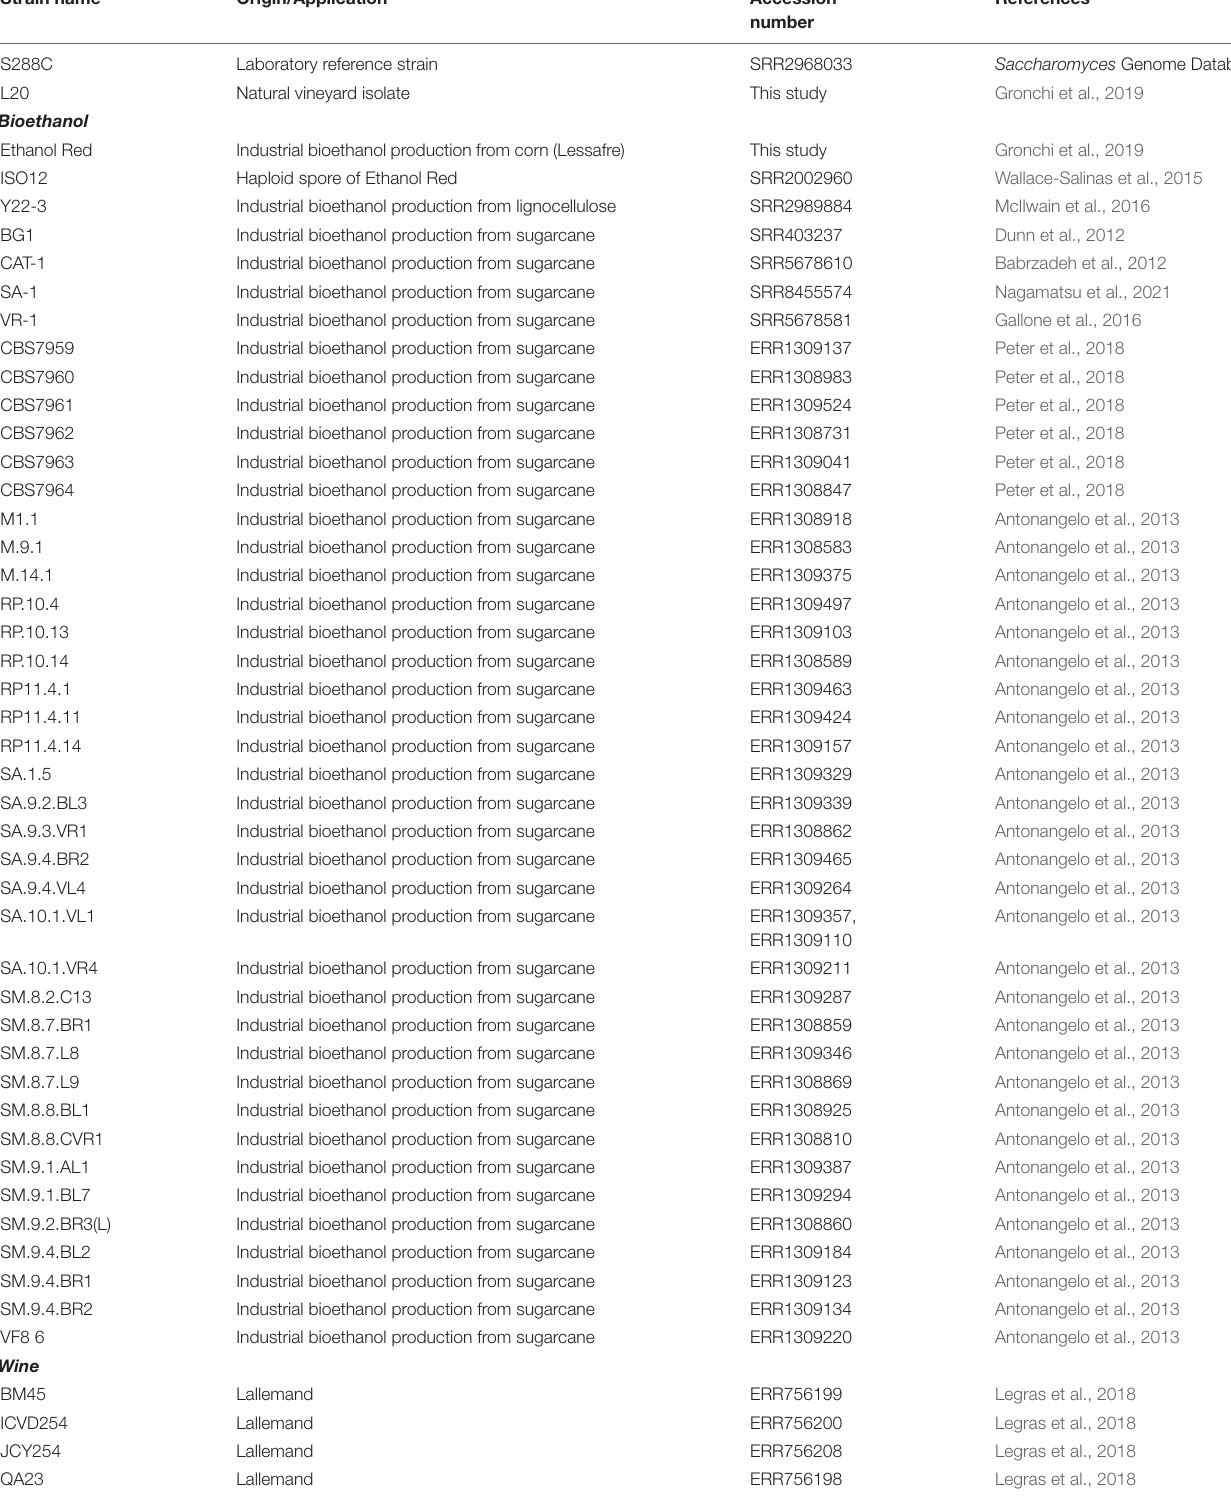
TABLE 2 | Yeast strains used in the comparative genomic